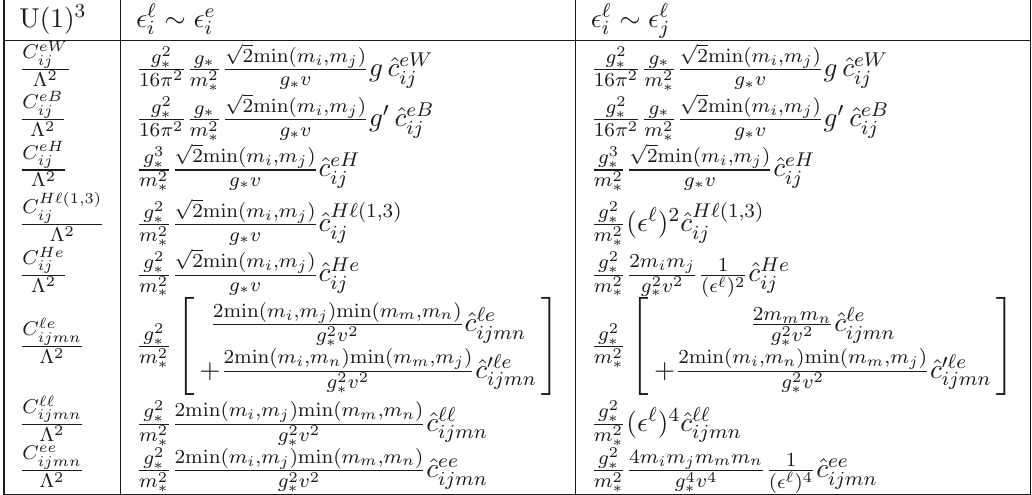
. As demonstrated in the i . i